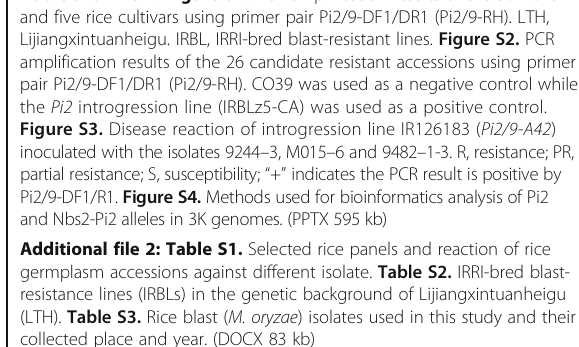
Additional file 1: Figure S1. PCR amplification results of the 30 IRBLs and five rice cultivars using primer pair Pi2/9-DF1/DR1 (Pi2/9-RH). LTH, Lijiangxintuanheigu. IRBL, IRRI-bred blast-resistant lines. Figure S2. PCR amplification results of the 26 candidate resistant accessions using primer pair Pi2/9-DF1/DR1 (Pi2/9-RH). CO39 was used as a negative control while the Pi2 introgression line (IRBLz5-CA) was used as a positive control. Figure S3. Disease reaction of introgression line IR126183 ( Pi2/9-A42 ) inoculated with the isolates 9244 – 3, M015 – 6 and 9482 – 1-3. R, resistance; PR, partial resistance; S, susceptibility; “ + ” indicates the PCR result is positive by Pi2/9-DF1/R1. Figure S4. Methods used for bioinformatics analysis of Pi2 and Nbs2-Pi2 alleles in 3K genomes. (PPTX 595 kb) Additional file 2: Table S1. Selected rice panels and reaction of rice germplasm accessions against different isolate. Table S2. IRRI-bred blast- resistance lines (IRBLs) in the genetic background of Lijiangxintuanheigu (LTH). Table S3. Rice blast ( M. oryzae ) isolates used in this study and